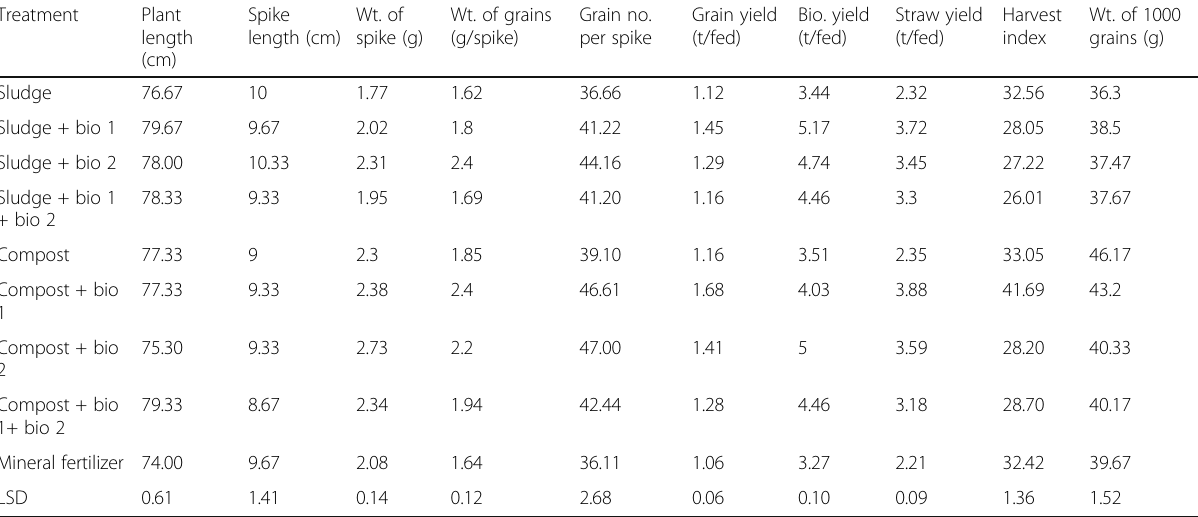
Table 3 Effect of compost, sludge, and biofertilizers on yield and yield components of wheat plants grown in newly reclaimed soil